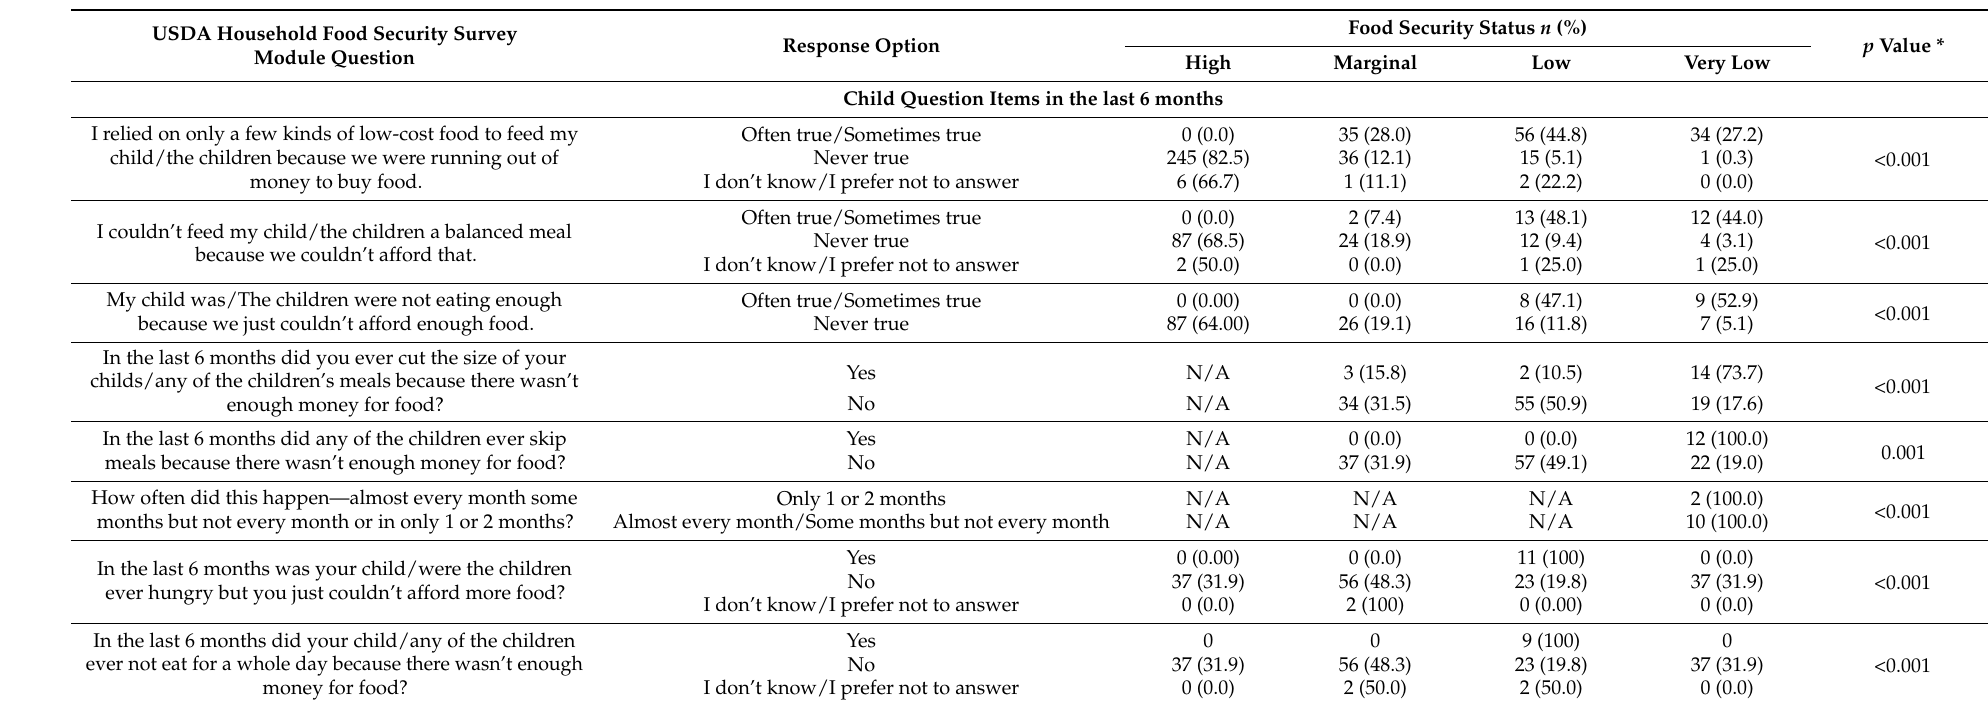
Table 2 footnotes: * p -value calculated via chi-squared. N/A represents questions that are not presented in the tool due to skip